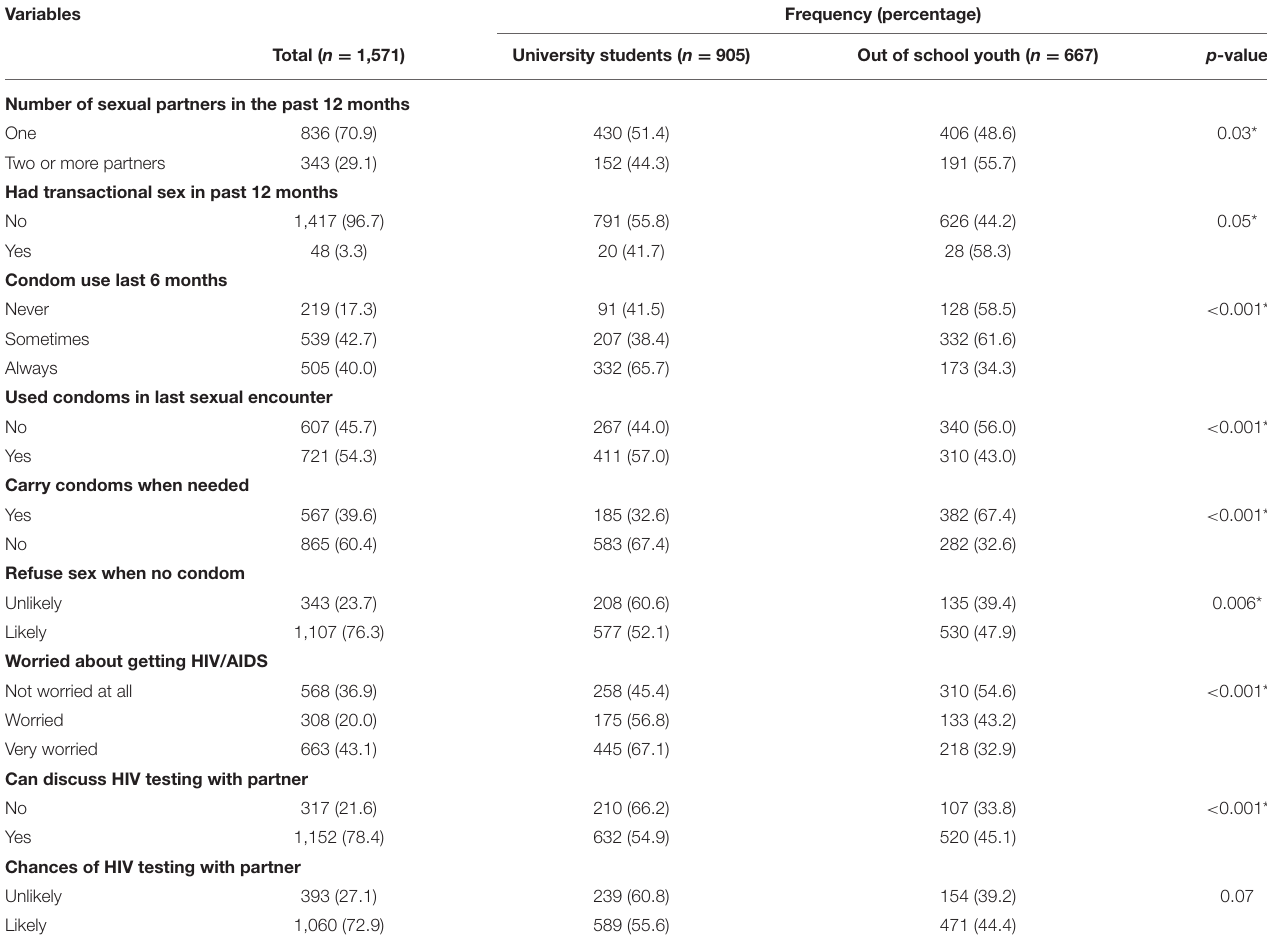
TABLE 2 | Risky sexual behavior. Variables